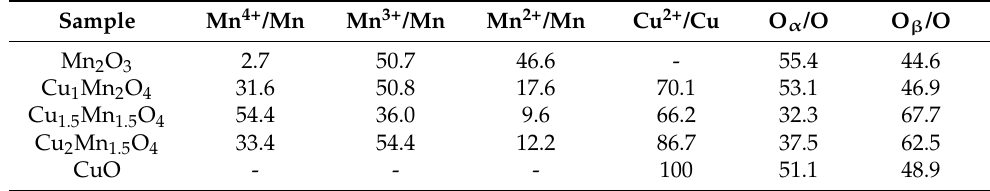
Figure 6. Survey spectra ( a ), Cu 2p ( b ), Mn 2p ( c ) and O 1 s, ( d ) XPS spectra of Cu x Mn 3 − x O 4 catalysts. Table 2. XPS results of all the